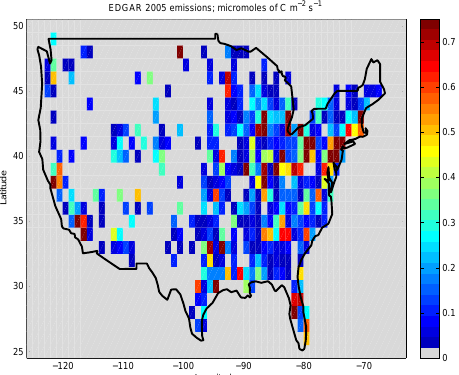
Figure 1. Plot of ffCO 2 emissions (micromoles of C m − 2 s − 1 ) as Figure 1. Plot of US ffCO 2 emissions (micromoles of C m − 2 s − 1 ) as reported by EDGAR for 2005. reported by EDGAR for 2005. Emissions below 0.02 micromoles Emissions below 0.02 micromoles of C m − 2 s − 1 are grayed out. of C m − 2 s − 1 are grayed